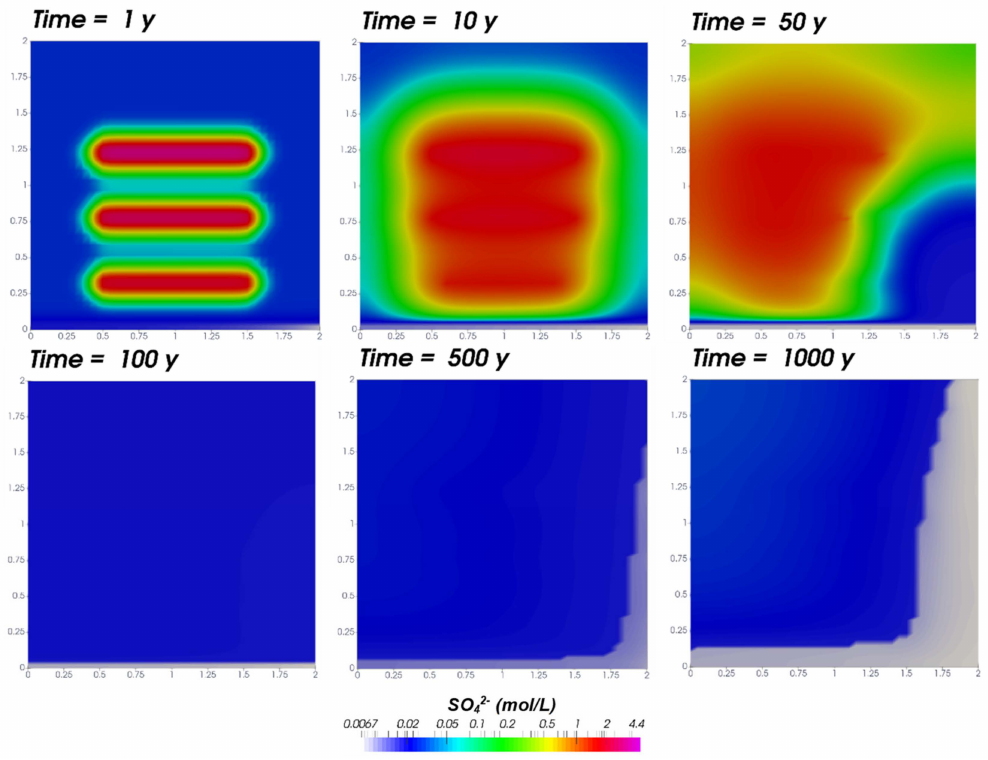
Figure 13. Spatial distribution of the concentration of dissolved SO 42 − at selected times in the simulation of scenario 4 (a log scale is used to map data to colors).